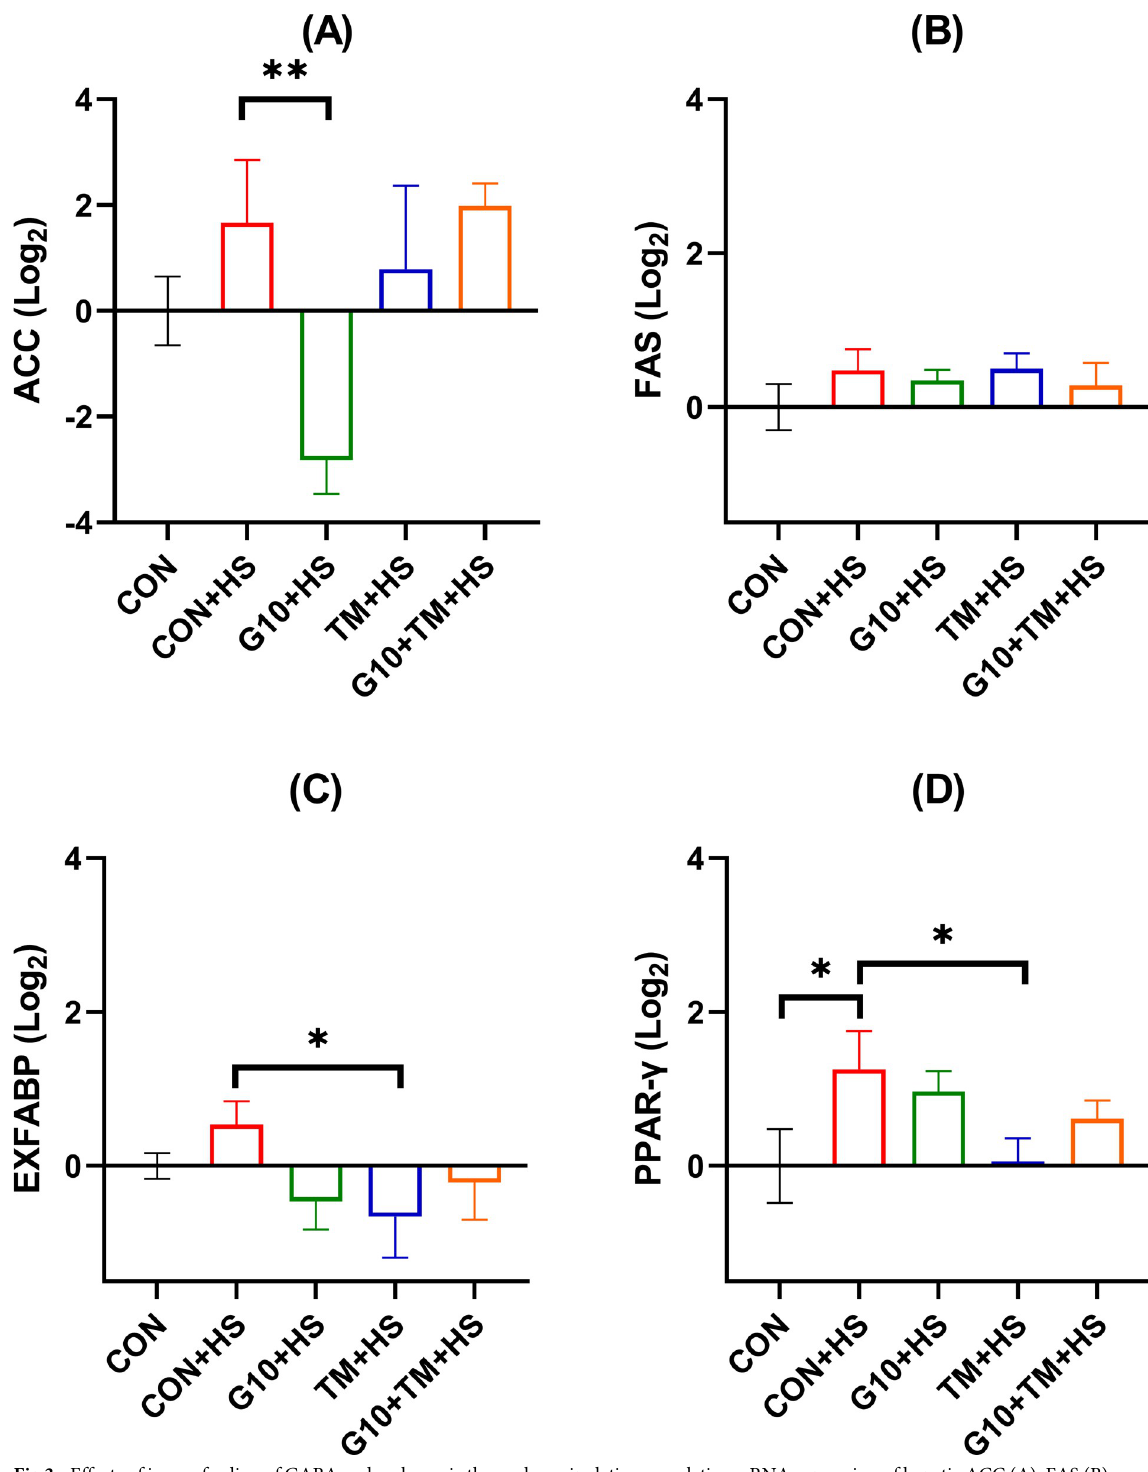
Fig 3. Effects of in ovo feeding of GABA and embryonic thermal manipulation on relative mRNA expression of hepatic ACC (A), FAS (B), EXFABP (C), and PPAR- γ (D) in broiler chickens exposed to cyclic HS. The treatments are described as follows: CON, chicks hatched from control eggs without in ovo injection and incubated at standard temperature; CON+HS, chicks hatched from control eggs without in ovo injection, incubated at standard temperature but exposed to HS; G10+HS, chicks hatched from eggs injected at 17.5 days of incubation with 0.6mL of 10% GABA dissolved in distilled water and exposed to HS; TM+HS, chicks hatched from thermally manipulated eggs exposed to